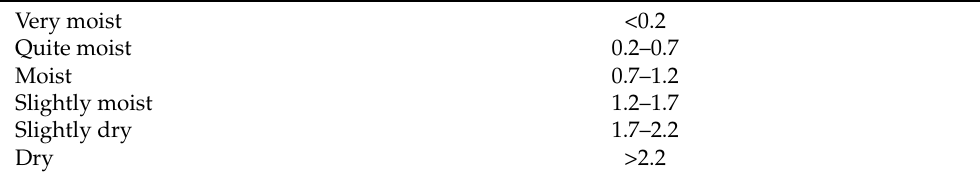
Table 8. Scale of moisture stress index